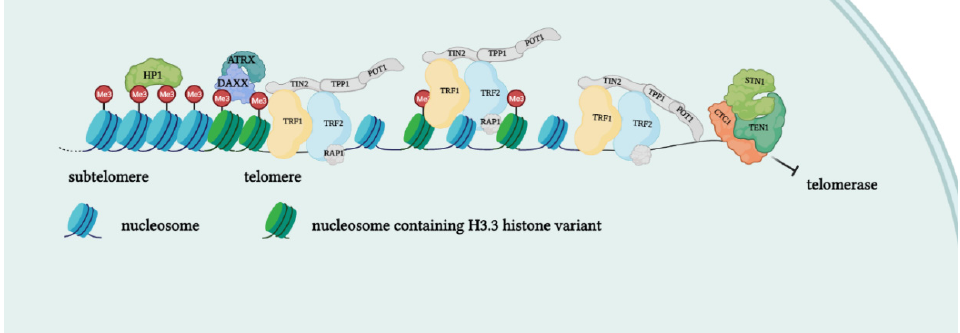
Figure 2. Protein complexes at telomeres. The shelterin complex binds telomeric sequences in an atypical nucleosome environment. Heterochromatic marks (histone trimethylation, HP1) and telomere-enriched histone variants (H3.3) are present. Telomeric ends are bound by the CST complex which antagonizes telomerase access.